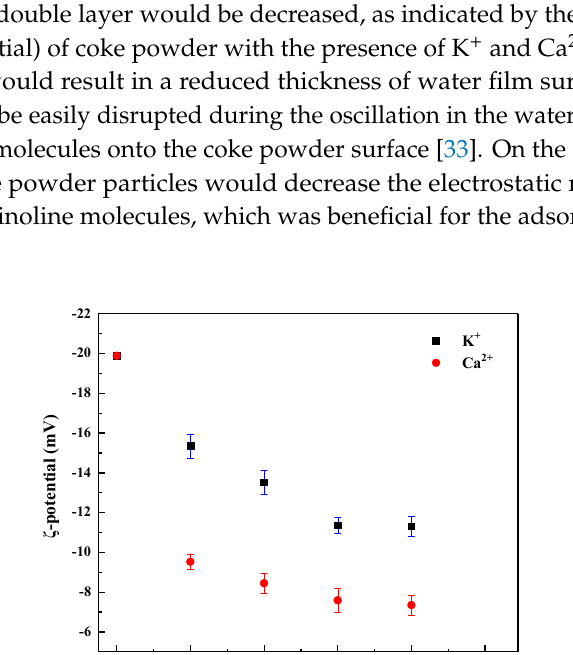
Figure 4. Variations in the adsorption capacity of coke powder and quinoline removal e ffi ciency in the absence and presence of ( a ) KCl and ( b ) CaCl 2 (the error bars represent the 95% confidence interval of the average values).